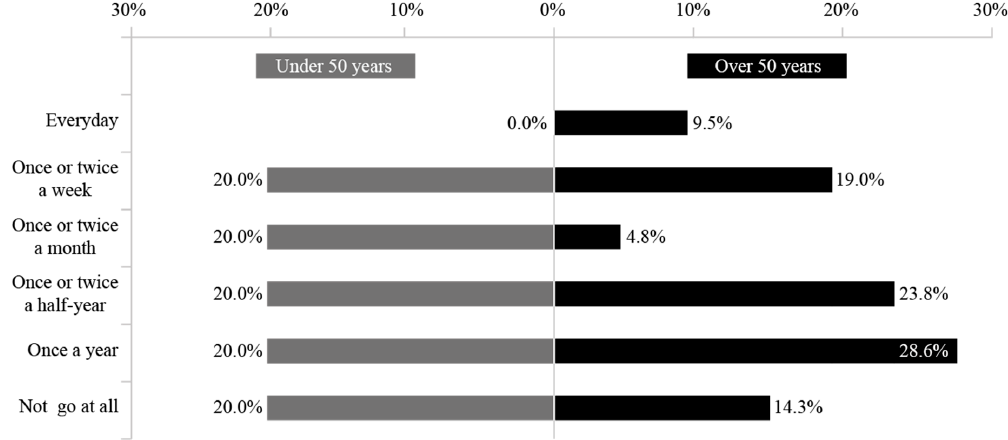
Figure 8. Frequency of visit by residence years after the reclamation project (n = 31).